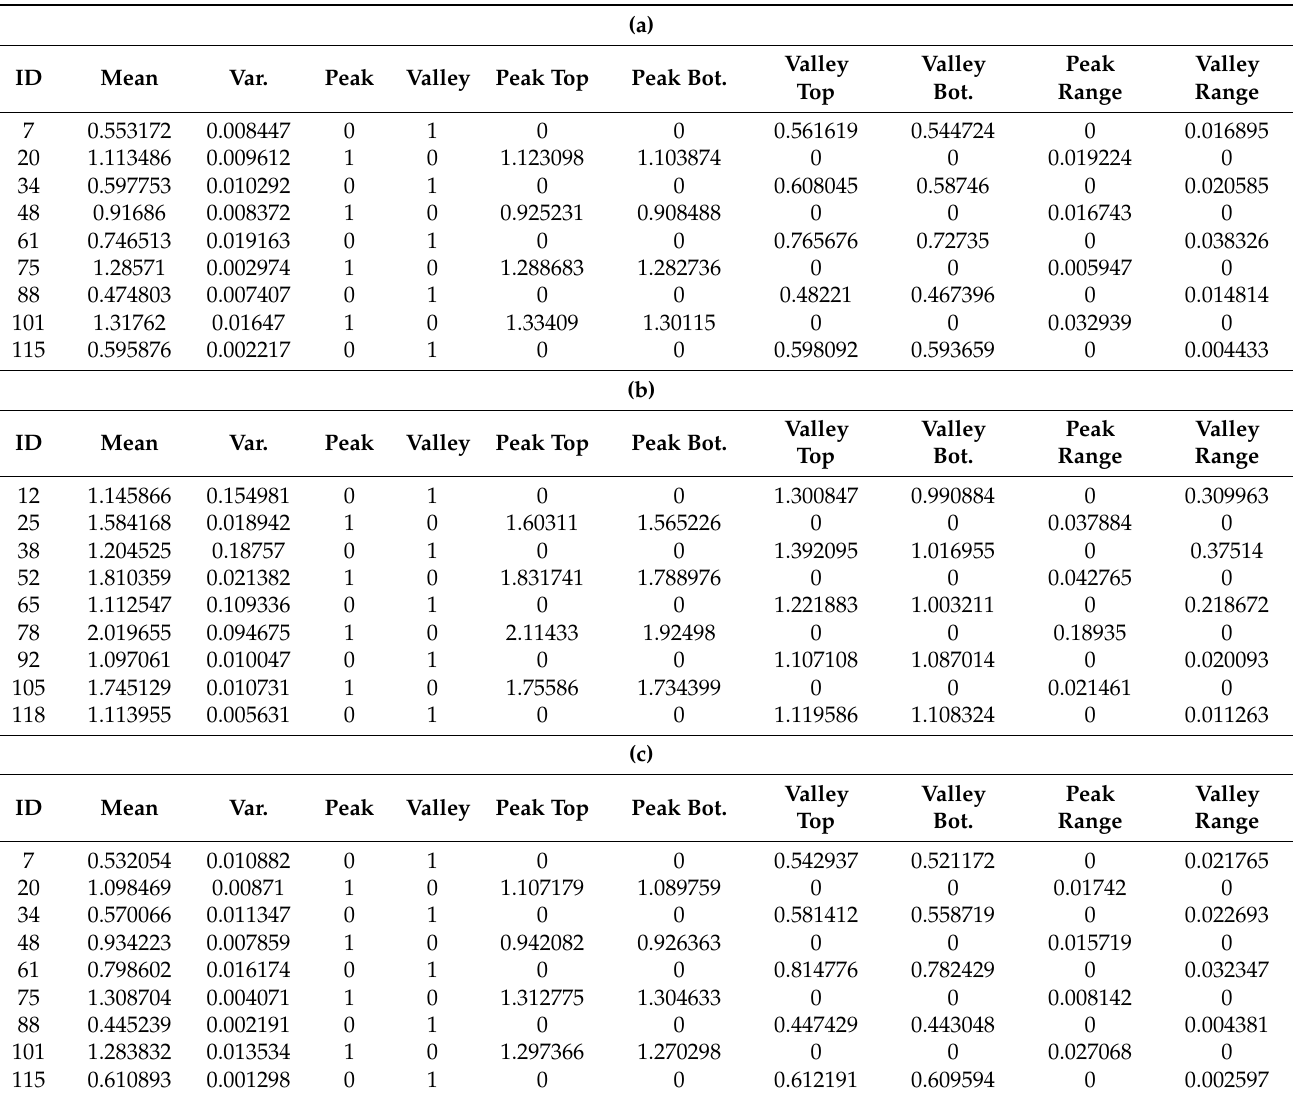
Table 2. Resampled, resmoothed mean–var. transformed data on the Y axis (WS = 6 m/s). ( a ) Min/var. peak/valley stats for the 3.0-blade turbine. ( b ) Min/var. peak/valley stats for the 2.5-blade turbine. ( c ) Min/var. peak/valley stats for the 2.0-blade